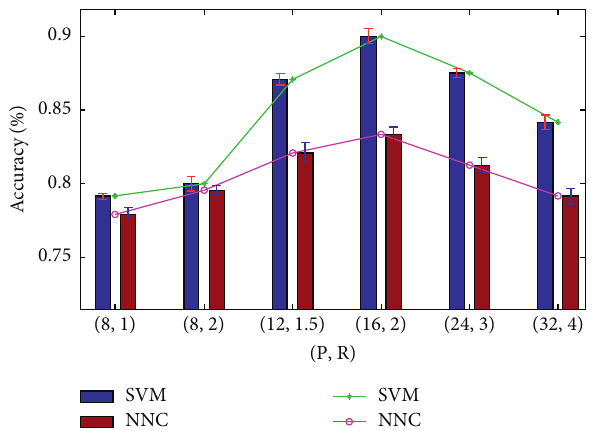
Figure 14: SVM parameter selection results by the grid search